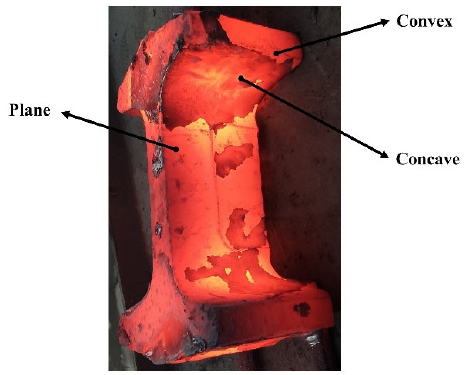
Figure 11. The special ‐ shaped hot forging of 300 M steel after descaling.